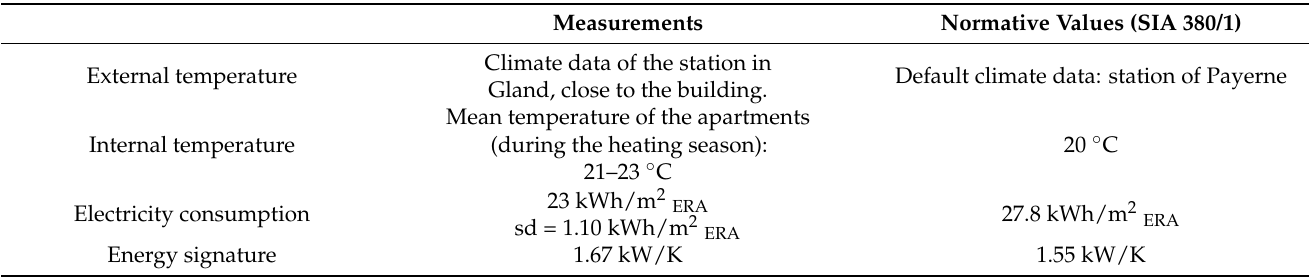
Table 3. Differences between the measurements and the normative values.